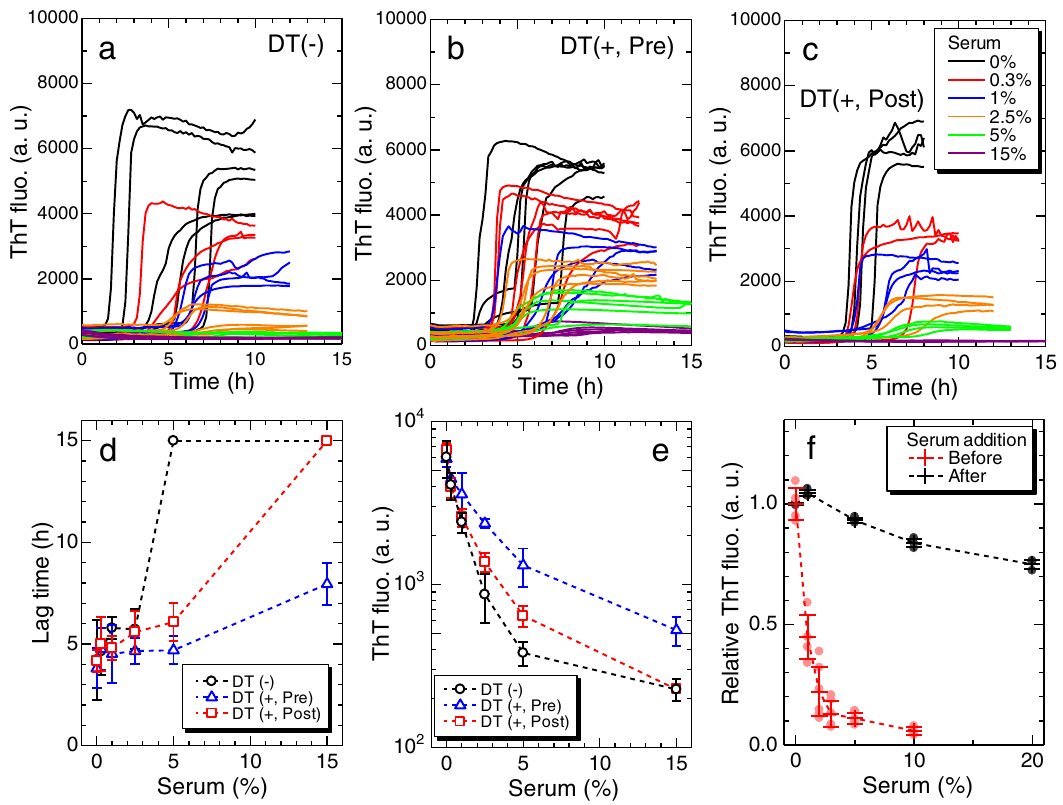
Fig. 2 | Concentration-dependent inhibitory effects of sera on β 2m amyloid fi bril formation. ThT fl uorescence kinetics at varying concentrations of sera collected from ( a ) a non-dialysis control (DT( − ), #9) and a dialysis patient immediately ( b ) before (DT(+, Pre), #8) and ( c ) after maintenance dialysis treat- ment (DT(+, Post), #8), respectively. For each condition, measurement was per- formed multiple times for independent solutions ( n ≥ 4). Dependence of ( d ) the